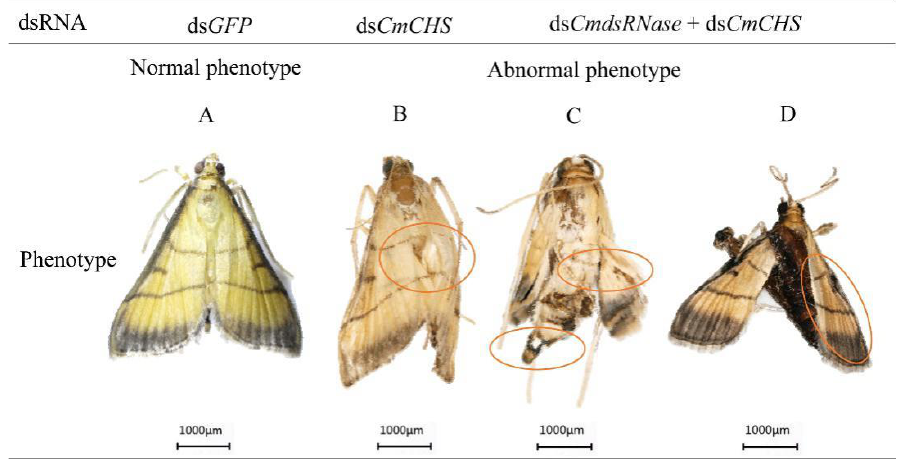
Figure 13. Abnormal morphology of C. medinalis adults after dsRNA injection. ( A ) ds GFP -injected adult. ( B ) Abnormal wing unfolding. ( C ) Wing and terminal abdominal deformities. ( D ) Adult deformity with pupa-shaped abdomen. Malformed phenotypes are marked with red circles. Each scale bar represents 1000 μ m.